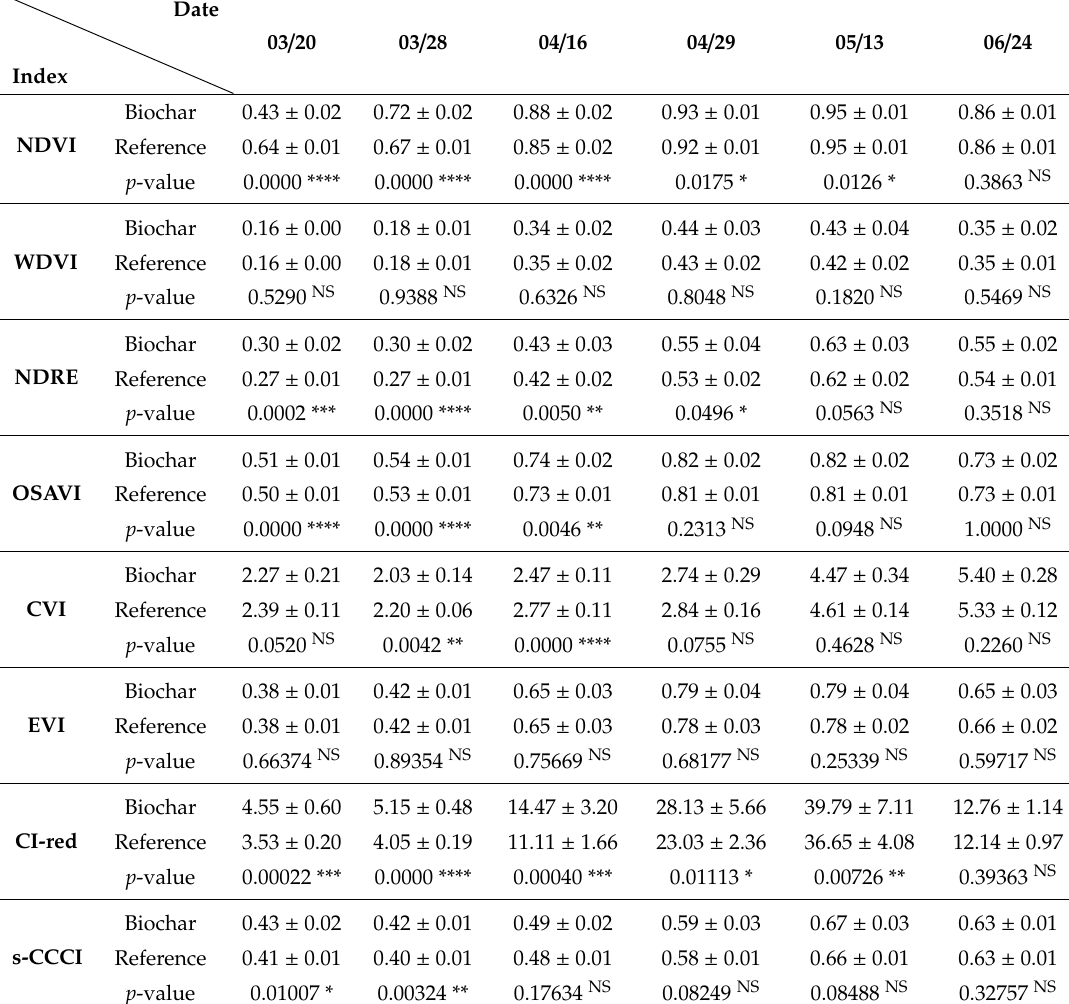
Table 3. Mean vegetation index values over the study area comparing the century-old biochar and reference plots during the growing season of 2019. The statistical significance of the di ff erence is expressed as the p-value of the paired t-test. Next to the p-values asterisks, *, **, ***, and **** reveal the statistical levels of significance and acronym NS stands for